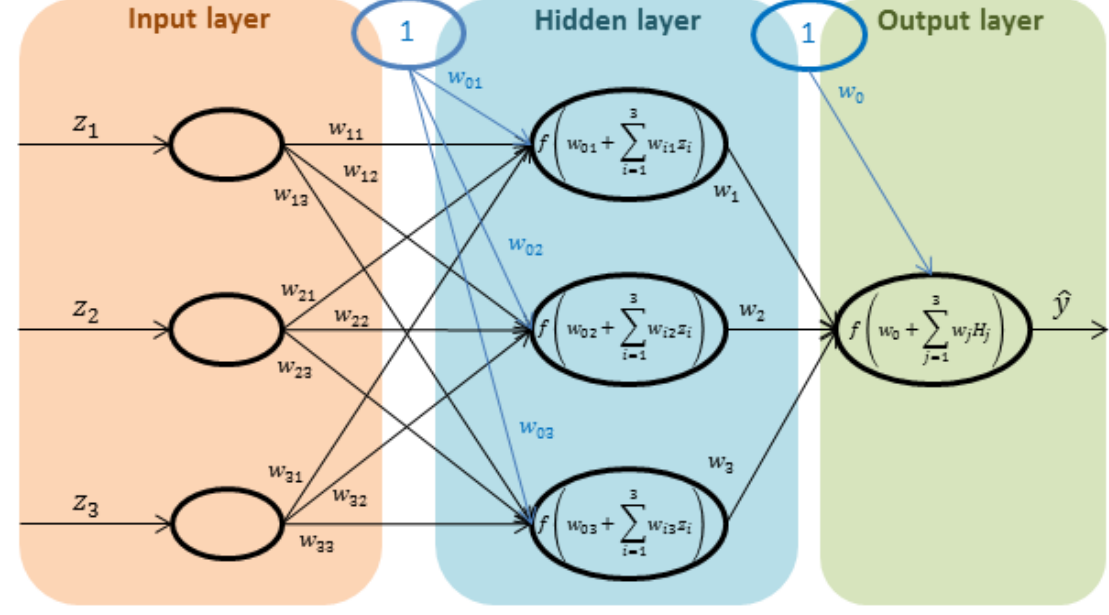
Figure 1. Example of an artificial neural network (ANN) with three input variables, one hidden layer with three neurons inside and one output neuron (representing target variable).